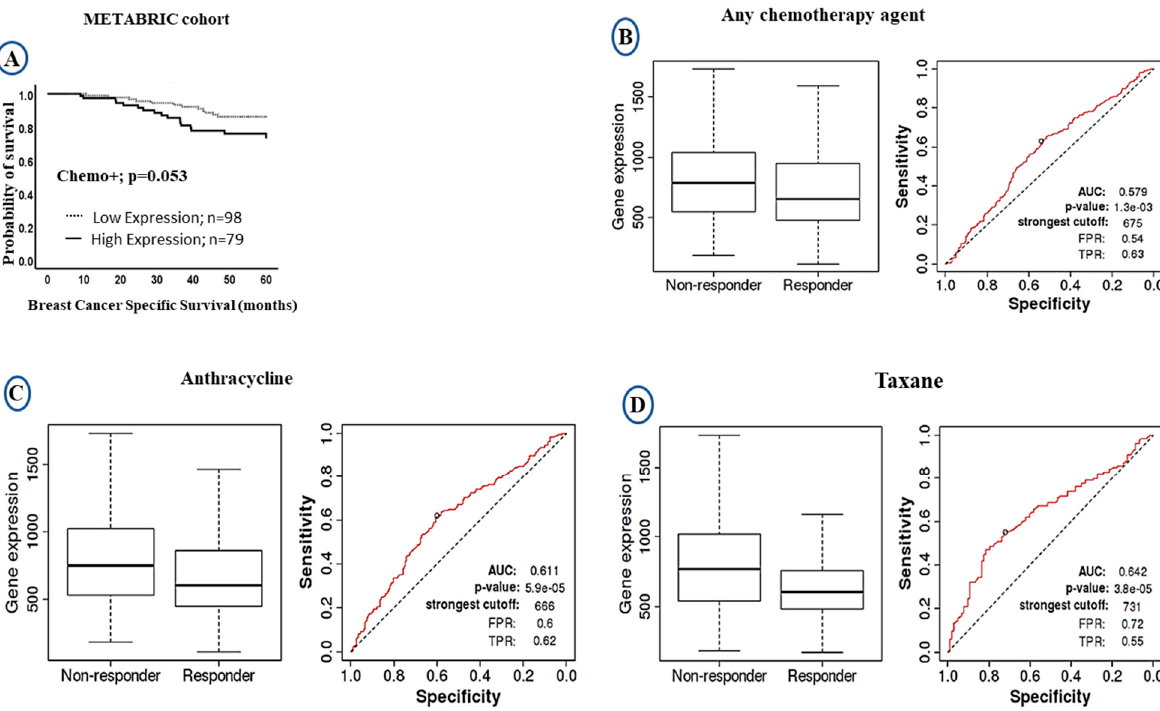
Figure 4. Kaplan–Meier Curves of LAIR-1 expression showing responsive and unresponsive cases to chemotherapy treatment: ( A ) Kaplan–Meier plots of BCSS in the METABRIC cohort showing LAIR-1 mRNA expression in patients who received chemotherapy. The receiver operator characteristic curve (ROC) in response to chemotherapy showing higher LAIR-1 expression was associated with non-responders ‘groups; ( B ) any type of chemotherapy agent, ( C ) anthracycline, and ( D ) taxane.